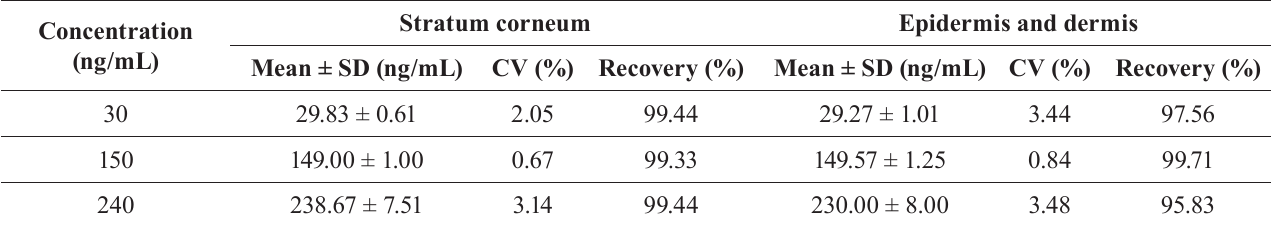
TABLE II - Mean values for recovery of the stratum corneum (spiked samples) and pig skin 450 (epidermis and dermis).